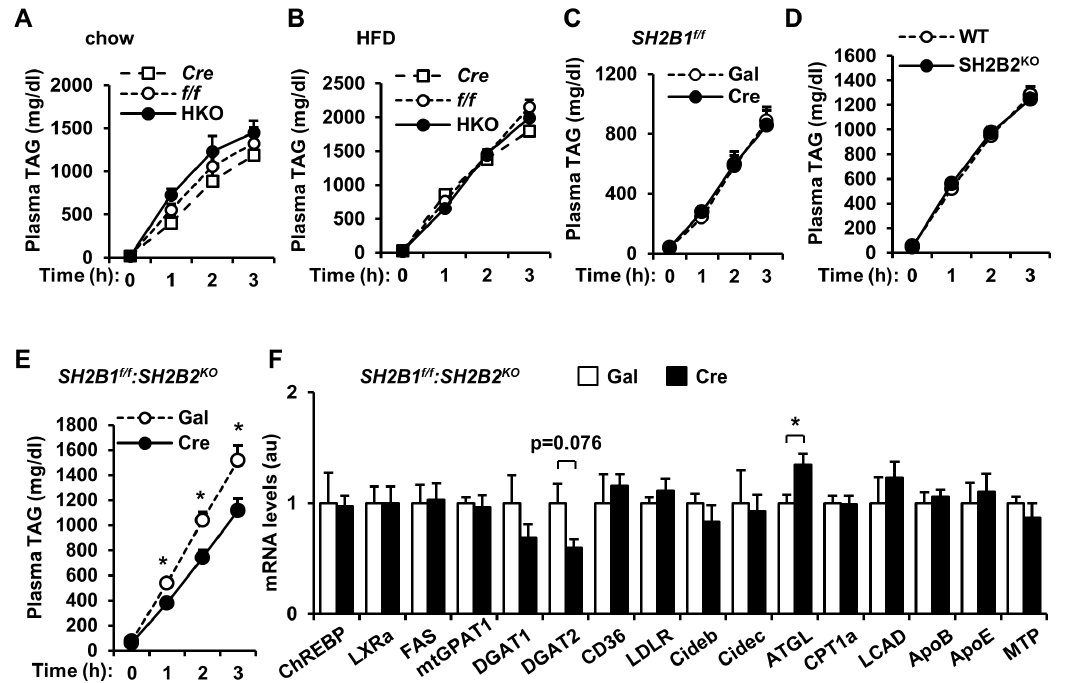
Figure 8. Deletion of both SH2B1 and SH2B2 in the liver suppresses VLDL secretion. (A) VLDL secretion in the mice (20 weeks of age) described in Fig. 7A. (B) Male mice (7 weeks of age) were fed a HFD for 13 weeks as described in Fig. 7B, and VLDL secretion was measured. (C) SH2B1 f/ f male mice were fed a HFD and infected with b -gal (n=7) or Cre adenoviruses (n=6) as described in Fig. 7C. VLDL secretion was measured 22 days after adenoviral infection. (D) VLDL secretion was measured in SH2B2 knockout and WT males (11 weeks of ages). SH2B2 KO : n=5; WT: n=5. (E-F) SH2B1 f/f :SH2B2 KO male mice were fed a HFD and infected with b -gal (n=6) or Cre adenoviruses (n=6) as described in Fig. 7D. (E) VLDL secretion was measured 22 days after adenoviral infection. (F) The expression of the indicated genes was measured by qPCR and normalized to b -actin expression. Data are presented as means 6 SEM. P , 0.05.